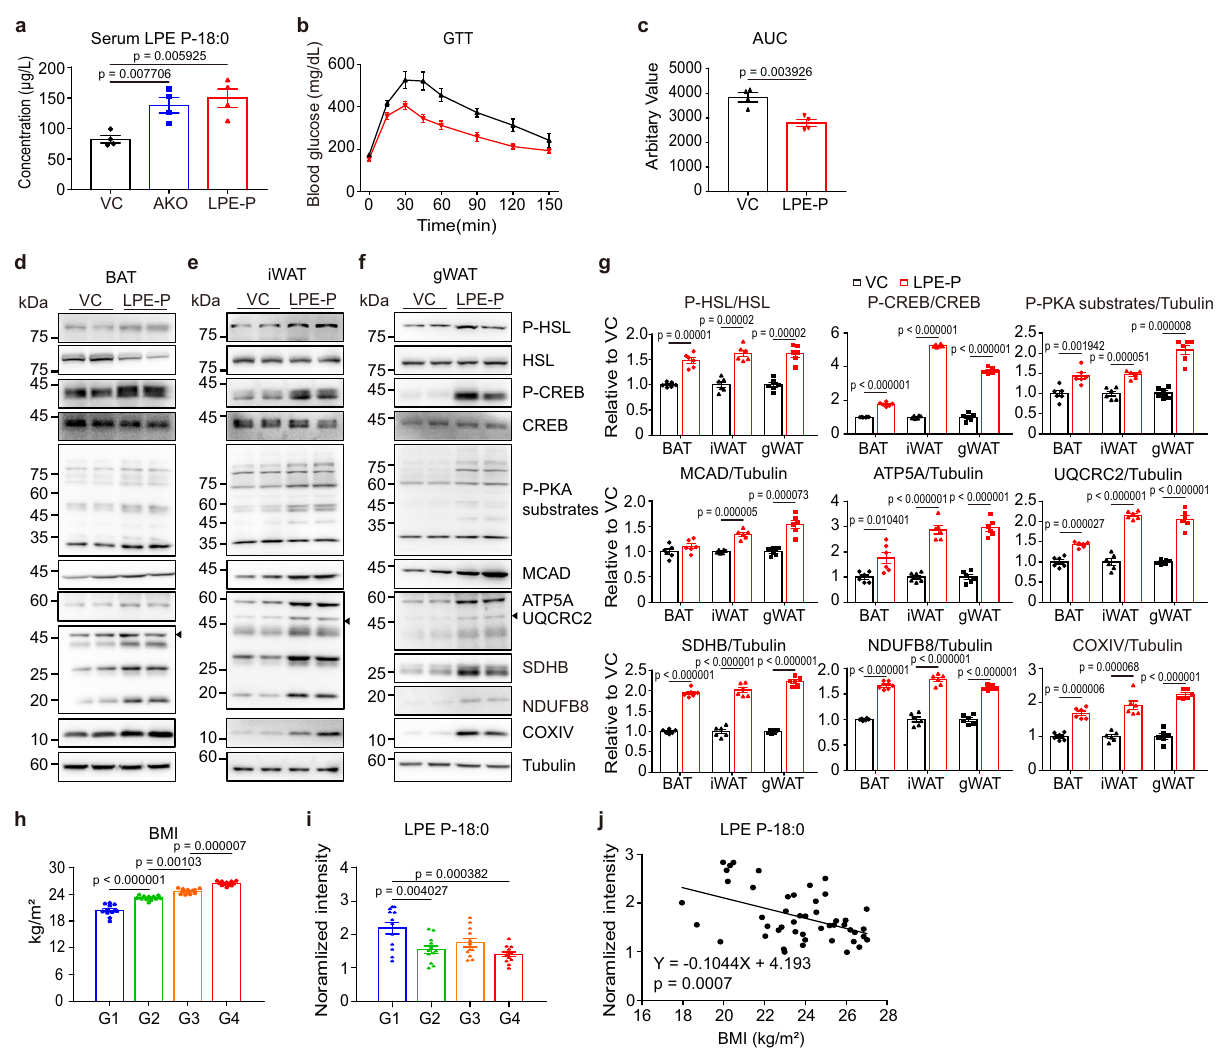
Fig. 8 LPE P-18:0 treatment facilitates mitochondrial oxidative metabolism and protects against diet-induced obesity. a Concentration of LPE P-18:0 (LPE-P) in serum of TMEM86A AKO mice or WT mice treated with either VC or LPE-P for 2 weeks (i.p. 200 μ g/kg/day). n = 4. b , c Intraperitoneal glucose tolerance test of WT mice fed a HFD treated intraperitoneally with VC or LPE-P for 2 weeks. n = 4. d – g Immunoblot analysis of BAT, iWAT and gWAT of WT mice fed a HFD treated with VC or LPE-P for 2 weeks (i.p. 200 μ g/kg/day). n = 6. h Grouping of 48 individuals in quartile according to body mass index (BMI). i Normalized intensities of lysoplasmalogen LPE P-18:0 in human subcutaneous adipose tissue (Intensity was normalized by median, *FDR < 0.05). n = 48. j Correlation analysis of normalized intensity of LPE P-18:0 with BMI. n = 48; linear regression of correlation; R = − 0.4717, p = 0.0007. Each point represents a biological replicate. Data are presented as mean ± SEM. Statistical signi fi cance was determined using the unpaired, two-tailed t -test in a , c , and g and using ANOVA (one-way, Tukey ’ s HSD post-hoc analysis) in h and i . Source data are provided as a Source Data fi